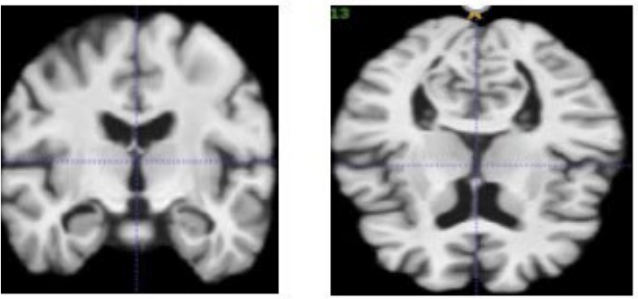
Figure 10. MRI after the brain extraction process.